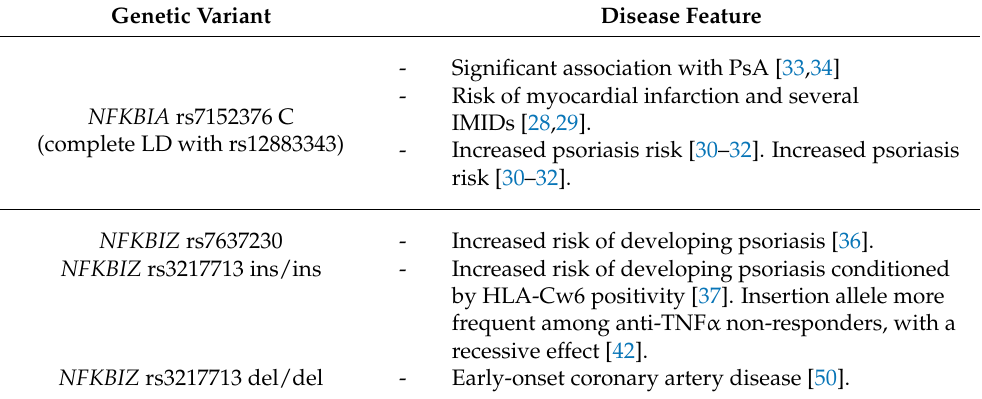
Table 1. Cont. Genetic Variant Disease Feature - Significant association with PsA [33,34] - Risk of myocardial infarction and several NFKBIA rs7152376 C (complete LD with rs12883343)